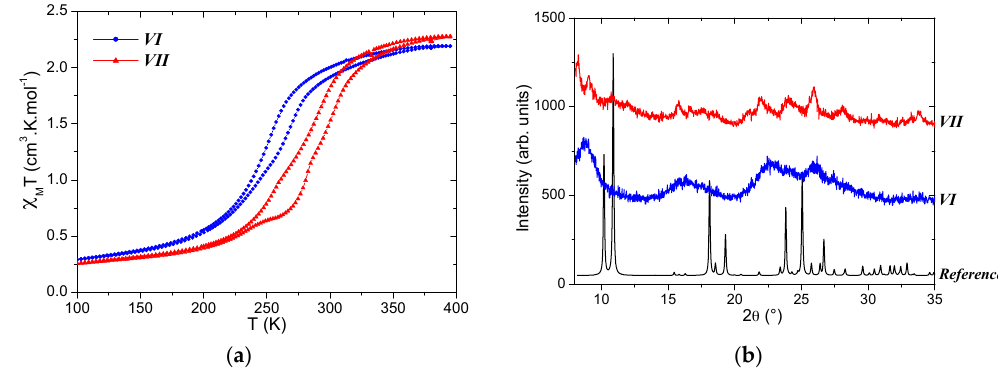
Figure 7. Physical characterizations of batches VI (blue) and VII (red) showing ( a ) χ M T as a function of temperature and ( b ) the PXRD patterns, including the reference one for trials to get [Fe(Htrz) 2 (trz)](BF 4 ). The latter corresponds to the orthorhombic unit-cell with a = 17.3100(9) Å; b = 7.3495(4) Å and c = 9.2149(5) Å [20].